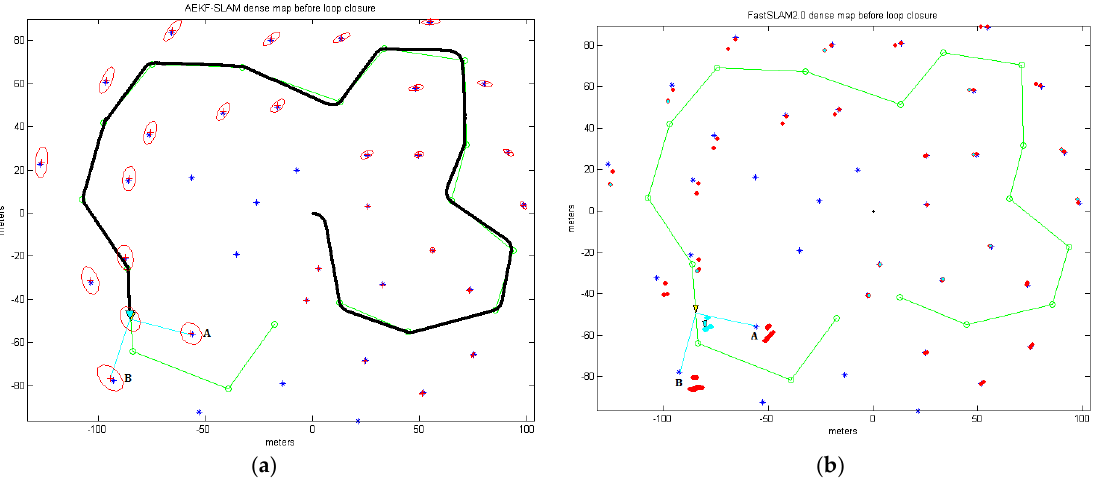
Figure 13. ( a ) The robot is observing the landmarks A and B in the AEKF-SLAM dense loop map; ( b ) The robot is getting measurements A and B in the FastSLAM 2.0 dense loop map.